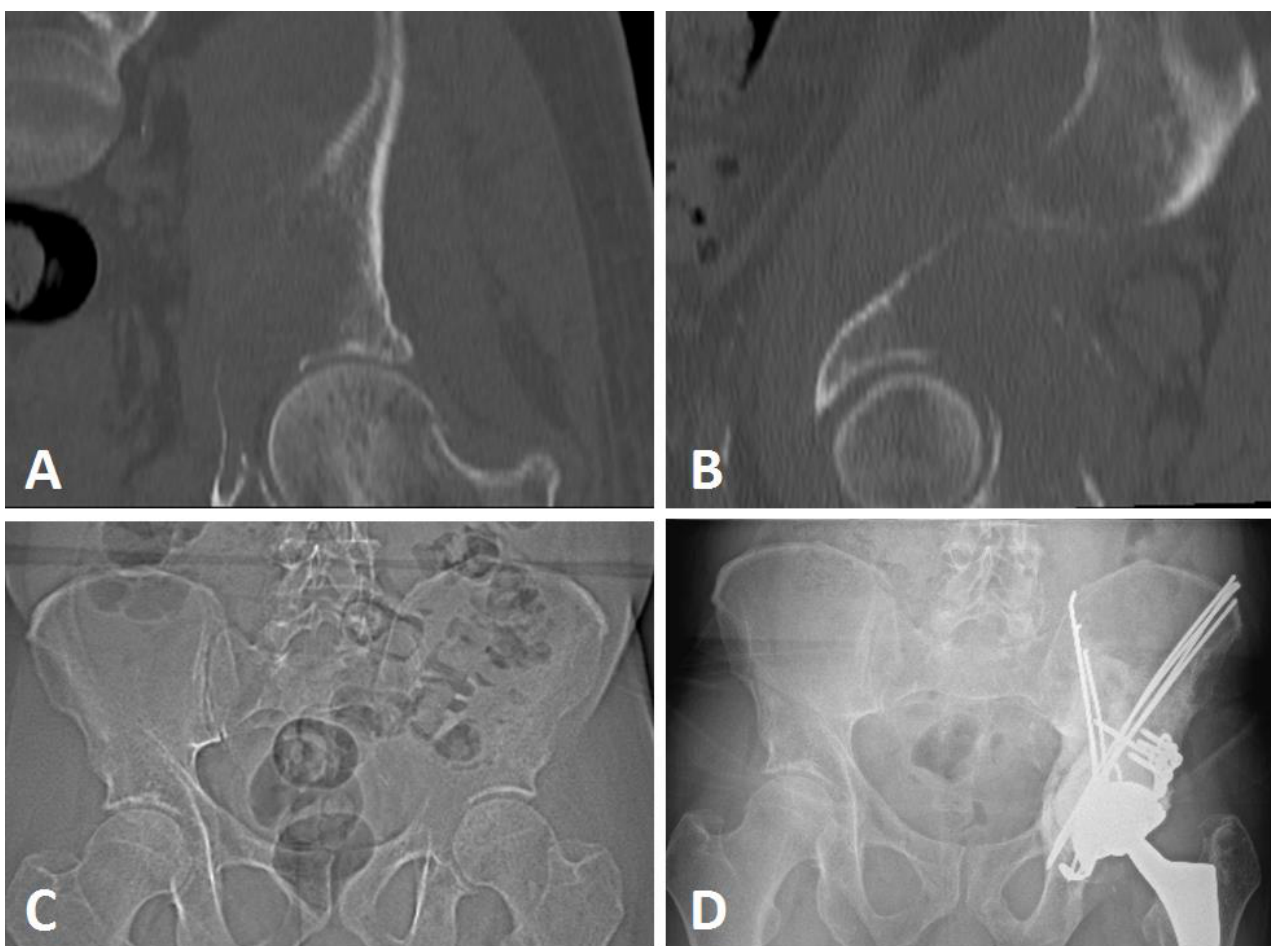
Figure 6. Kaplan – Meier curve for patient overall survival depending on the Katagiri risk score, with log-rank analysis ( p = 0.038).